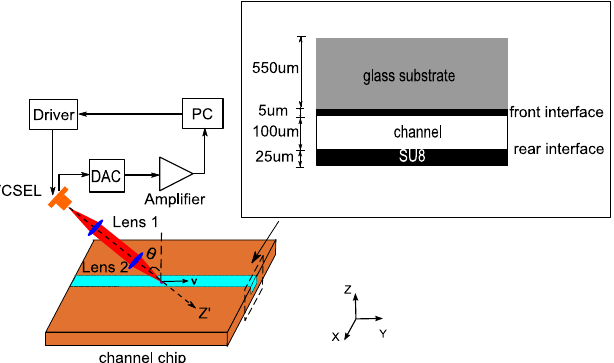
Figure 4. Schematic of the experimental setup (inset: cross section of the microfluidic channel